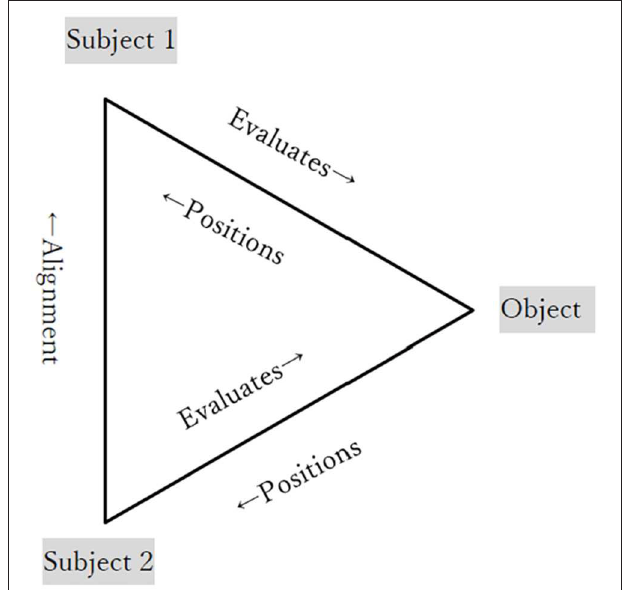
FIGURE 1 | Stance-taking triangle by Du Bois (2007).